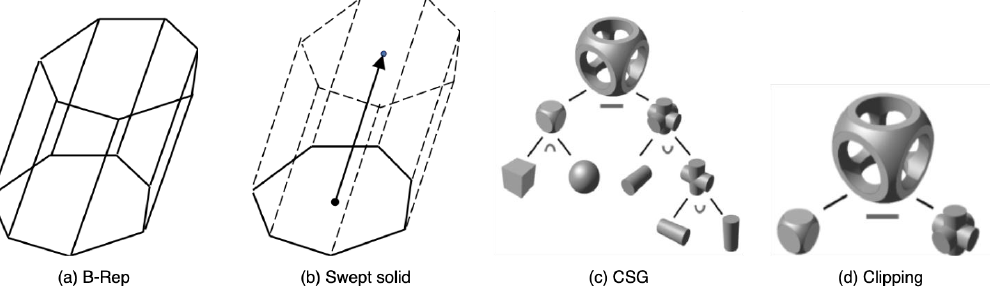
Figure 1. Basic representation methods used in IFC. ( a ) Boundary representation (B-Rep); ( b ) swept Solid; ( c ) constructive solid geometry (CSG) [21]; and ( d ) clipping.